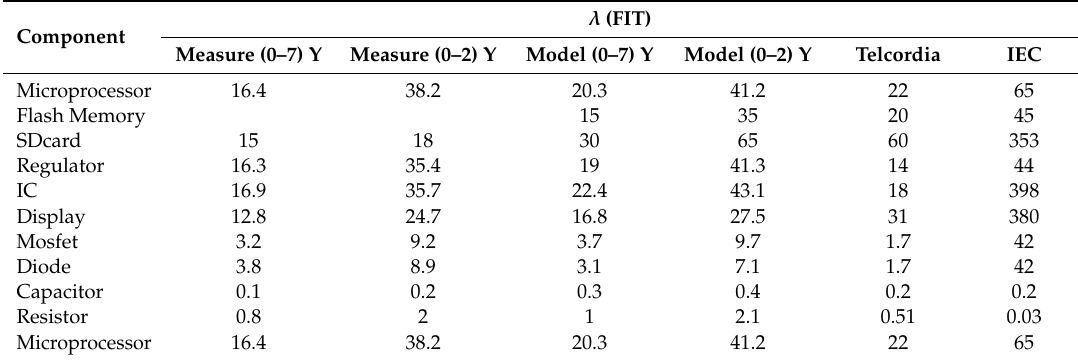
Table 2. Failure rate of the single components expressed in FIT (FIT = 1 / 10 9 h) for the four methodologies: Telcordia, IEC experimental data and our model.